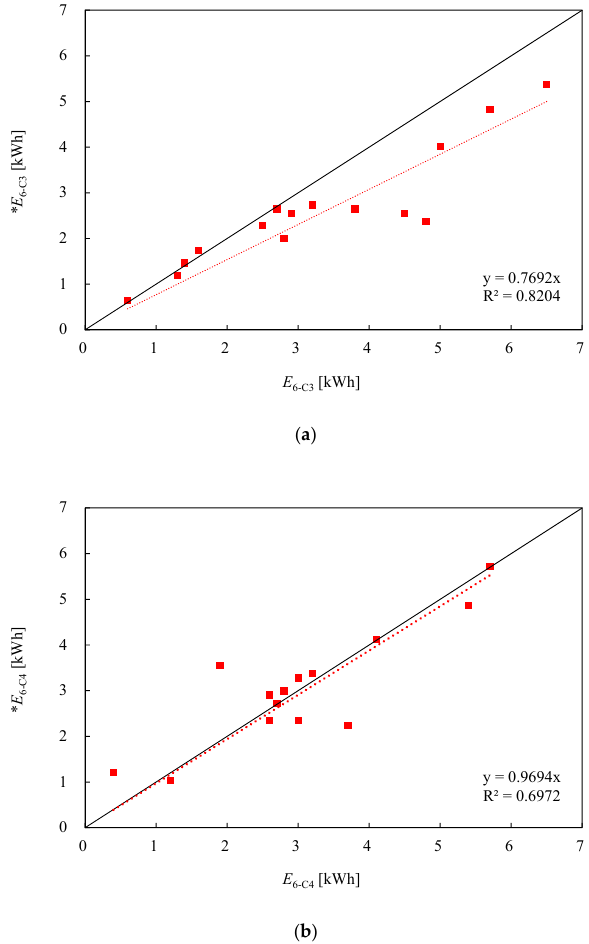
Figure 10. Corrected electricity consumption (* E ) versus actual consumption ( E ) for ( a ) 6-C3 and ( b ) 6-C4.